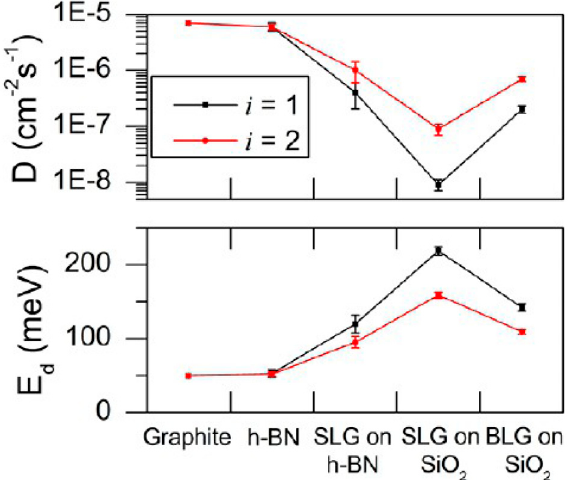
Figure 22. The calculated diffusion energy, E d , and diffusion constant, D, of Au adatoms on various surfaces: graphite, hexagonal boron nitride (h-BN), single-layer graphene (SLG) on h-BN, SLG on SiO 2 , and bilayer graphene (BLG) on SiO 2 . Calculations using different critical sizes i are given in black ( i = 1) and red ( i = 2) curves for comparison. For graphite, E d and D are assumed as 50 meV and 7 × 10 − 6 cm 2 s − 1 , independent of critical size i . Reproduced from Reference [60] with permission from the American Chemical Society.